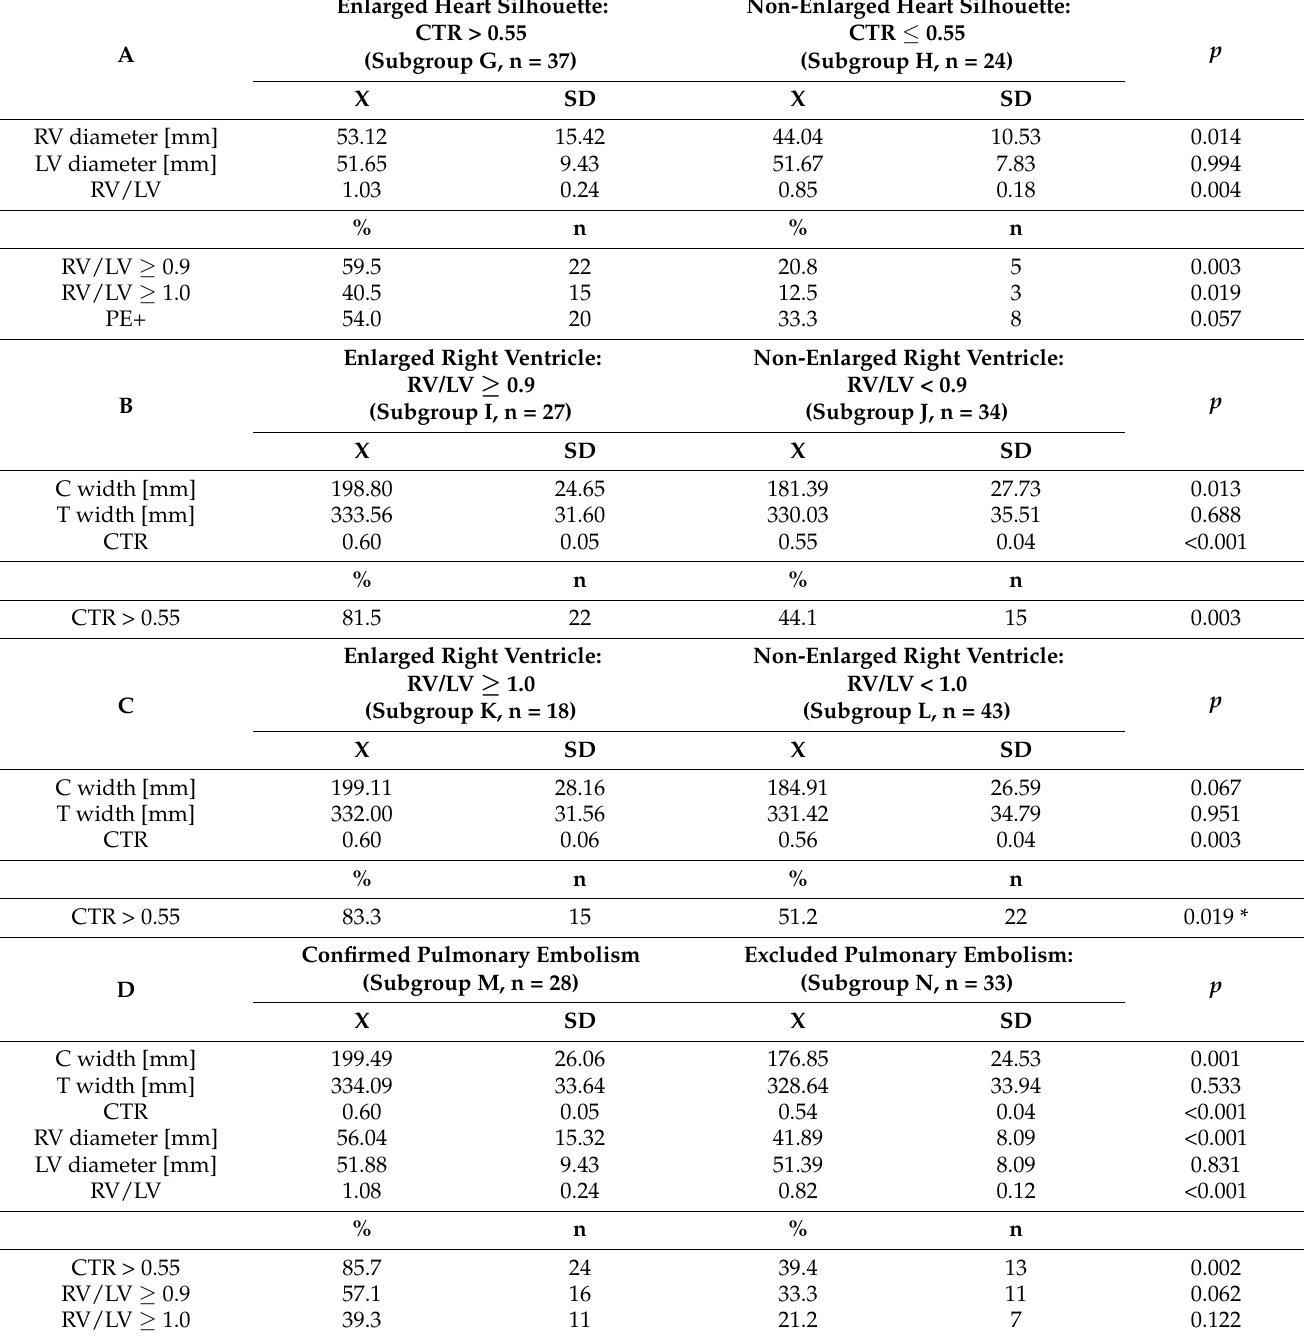
Table 4. The size of the heart silhouette in the chest radiograph and selected variables in the CTA examination of the pulmonary arteries in the study subgroups. (A) Selected variables of pulmonary artery CTA in the study subgroups divided according to the criterion of cardiac enlargement in the chest radiograph. (B) The size of the heart silhouette in the chest radiograph in the study subgroups divided according to the criterion of right ventricular enlargement in the CTA of pulmonary arteries (if RV/LV ≥ 0.9 defines right ventricular enlargement). (C) The size of the heart silhouette in the chest radiograph in the study subgroups divided according to the criterion of right ventricular enlargement in the CTA of pulmonary arteries (if RV/LV ≥ 1.0 defines right ventricular enlargement). (D) The size of the heart silhouette in the chest radiograph and selected variables of the CTA of the pulmonary arteries in the study subgroups divided according to the criterion of pulmonary embolism in the CTA of the pulmonary